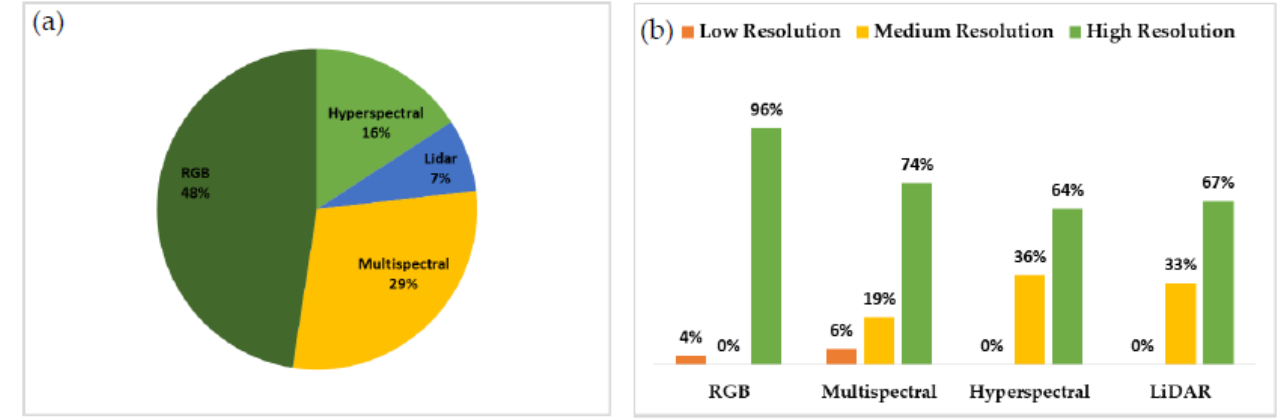
Figure 5. ( a ) Number of studies per sensor technology. ( b ) Image spatial resolution vs. sensor type. The increasing number of UAVs equipped with RGB commercial cameras has facili-